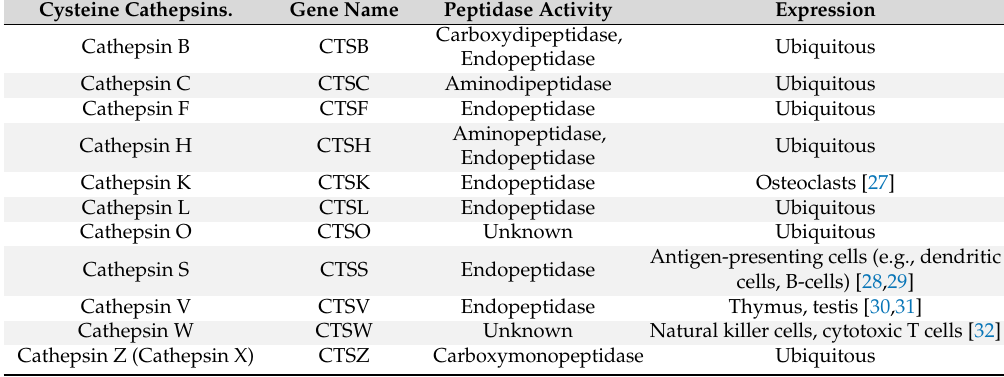
Table 1. Cysteine cathepsins. Overview of cysteine cathepsins, their peptidase activities, expression, and gene names according to the HUGO Gene Nomenclature Committee.